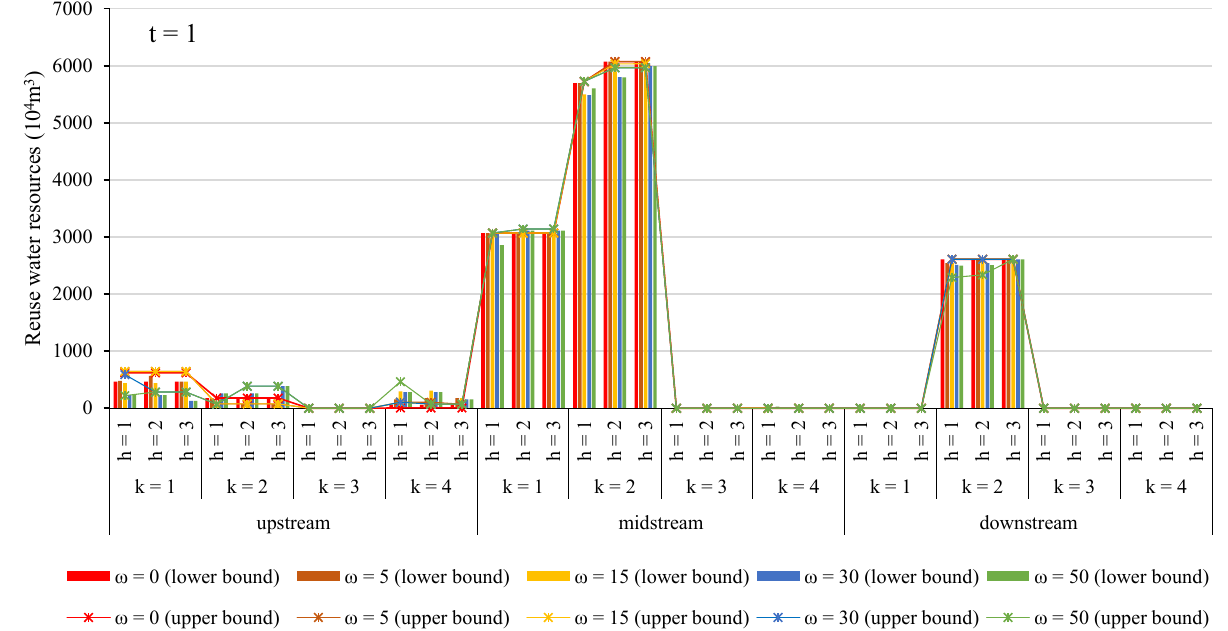
Figure 11. Reused water resources by region in the Fenhe River Basin in period 1.